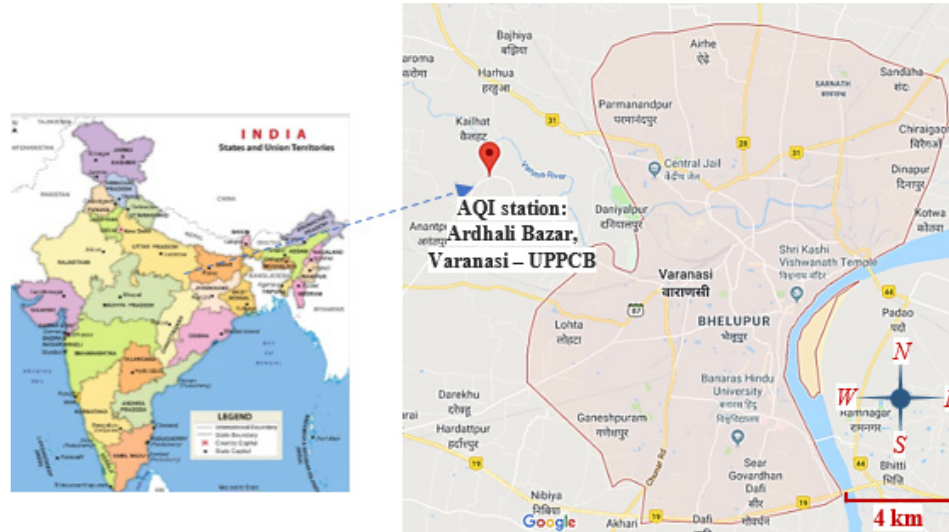
Fig. 1: Geographic location and map of air quality index station for the study area